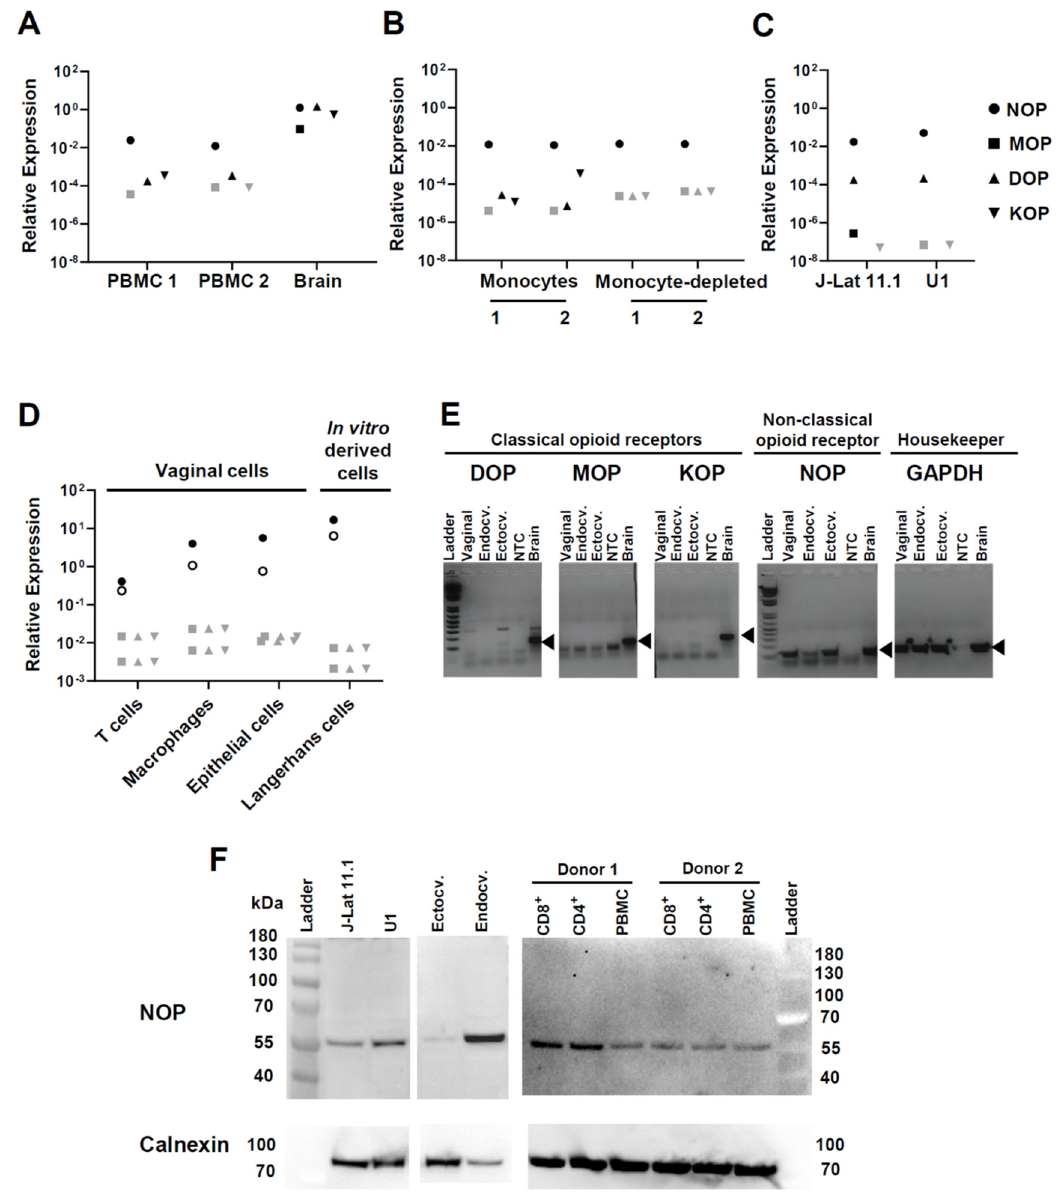
Figure 1. Expression of opioid receptors in different primary cells. RNA isolated from the indicated cell types was assessed for expression of opioid receptors by qPCR. NOP indicates the non-classical nociceptin/orphanin FQ (N/OFQ) peptide (NOP) receptor (OPRL1); MOP indicates the mu receptor (OPRM1); DOP the delta receptor (OPRD1) and KOP the kappa receptor (OPRK1). Relative expression of each receptor was defined as 2 −Δ C t . Δ C t is calculated as: Δ C t = C t (opioid receptor) − C t (PPIA or GAPDH). Each symbol represents the average of technical duplicates. ( A ) PBMC were from two healthy donors, and brain RNA was purchased. Opioid receptor expression on the y -axis is relative to the housekeeping gene PPIA. Similar results were obtained when GAPDH was used as normalizer (not shown). For a given opioid receptor qPCR analysis, samples with negative amplification (i.e., C t > 40) are denoted with gray shaded symbols. ( B ) Gene expression analysis was done in the monocyte-enriched and monocyte-depleted fractions derived from PBMC of two additional healthy donors. ( C ) Gene expression analysis in the two cellular models of HIV-1 latency: J-Lat clone 11.1 and U1 promonocytic cells. Two independent cultures of each cell line were analyzed separately; symbols represent the average of these cultures. ( D ) Vaginal T cells, macrophages, and epithelial cells were sorted from healthy vaginal tissues from two donors, and Langerhans cells were differentiated in vitro from hematopoietic precursors, as explained in Materials and Methods. Data represent gene expression levels per receptor and per donor (each donor is represented with either an open or close circle). Samples with negative amplification (i.e., C t > 40) are denoted with gray shaded symbols. ( E ) Gel electrophoresis analysis of qPCR